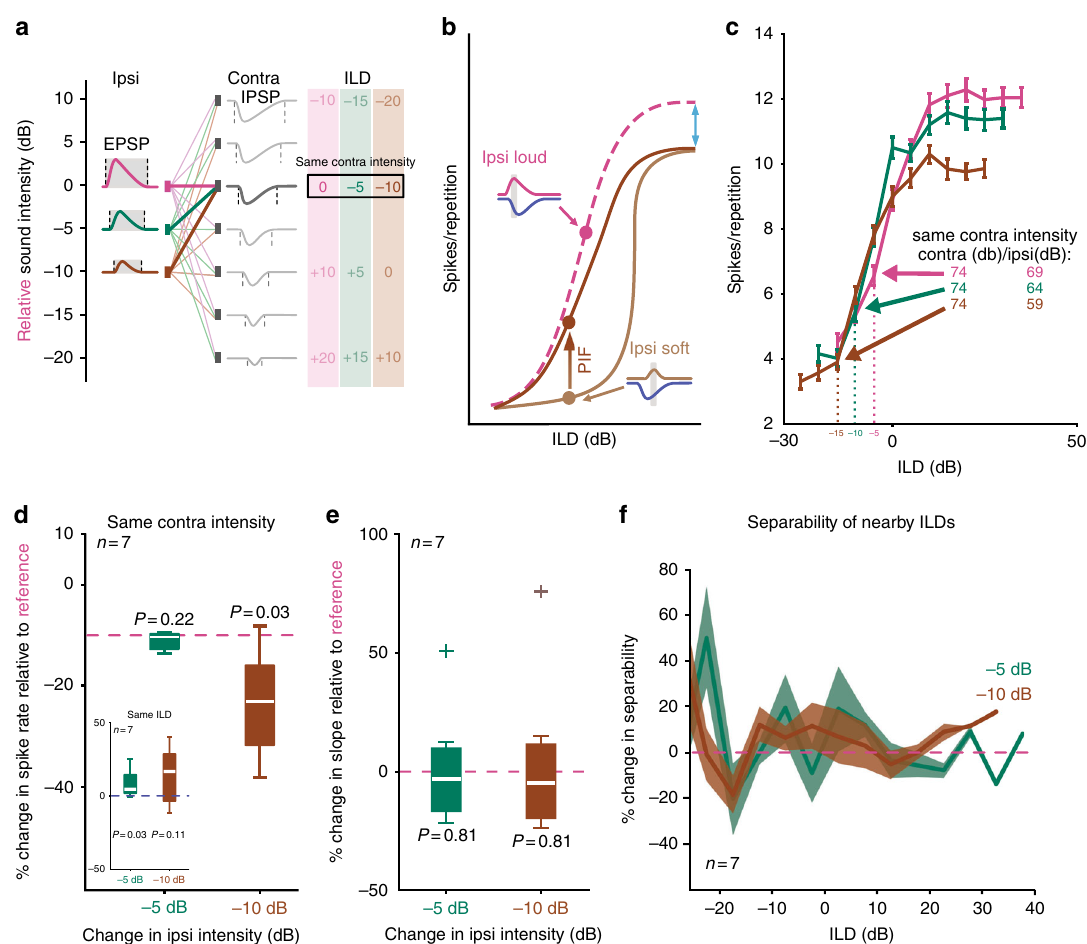
Fig. 6 A functional role of post-inhibitory facilitation in the LSO. a Schematic of the stimulus design. Left: three ipsi sound intensities, normalized to the loudest (magenta ≙ 0 dB) were combined with a wide range of contra intensities. b Schematic of hypothetical ILD-response functions during soft (light brown) or loud (magenta) ipsilateral stimulation. Soft ipsi stimulation not only lowers spike rates at ipsi-favoring ILDs (blue arrow), but also increases the relative potency of the inhibition due to both amplitude and timing effects, resulting in a diminished dynamic range (steeper slope) under soft ipsilateral starting conditions. However, higher contra intensities are likely to cause the IPSP to precede the EPSP and thus generate PIF, which in turn can recover the dynamic range of the ILD-response function by an increase in spike probability along the slope (dark brown). c ILD-response functions of an example neuron (CF: ~16.2 kHz) in response to the three different ipsi conditions (color-coded) as introduced in a . Data are presented as mean ± s.e.m. d Changes in spike rates along the slopes of the ILD-response functions were only slightly affected by decreased ipsi intensities ( − 5 dB: − 0.37% median change, interquartile range − 2.75 – 0.24%; P = 0.22, Wilcoxon signed rank test; − 10 dB: 13.0% median change, interquartile range − 21.5 to − 5.9%; P = 0.03, Wilcoxon signed rank test, n = 7 neurons). Inset: spike rates at identical ILDs were increased during reduced ipsi intensities ( − 5 dB: 4.4% median change, interquartile range: 1.9 – 14.3%, P = 0.03; − 10 dB: 16.6% median change, interquartile range: − 3.5 – 28.4%, P = 0.11, n = 7 cells). White horizontal bars